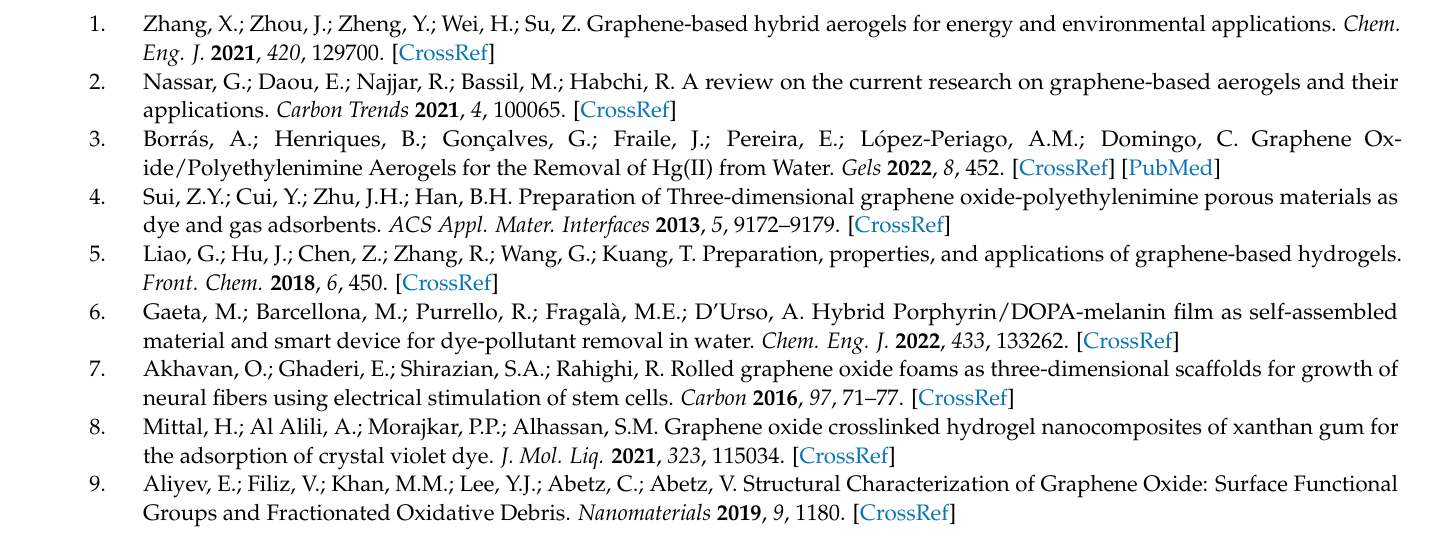
Figure S2: Calibration curve for Indigo Carmine. Figure S3: Calibration curve for Cibacron Brilliant Yellow. Figure S4: ATR FT-IR spectrum of GO-CS aerogels [51]. Table S1: Numerical values of the parameters obtained through the nano-computed